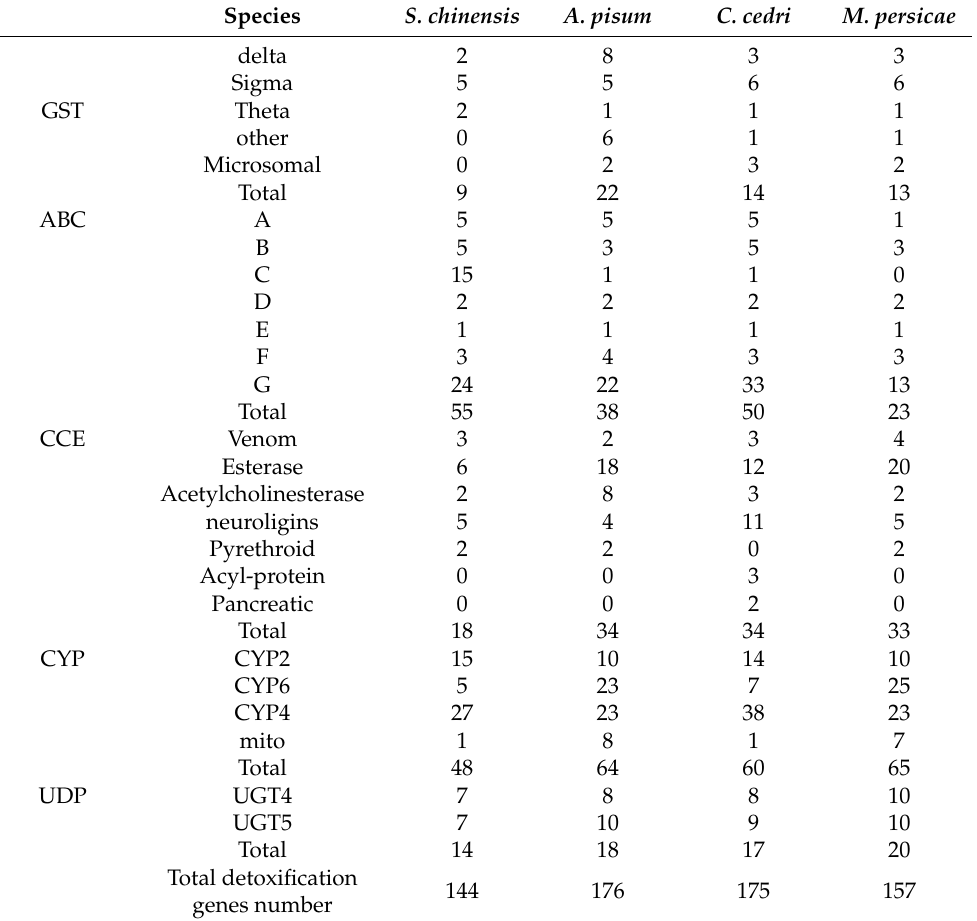
Table 1. Comparison of detoxification gene numbers in annotated insect species.